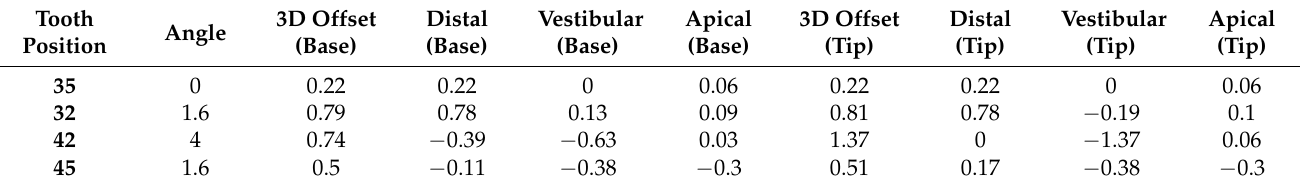
Table 2. Accuracy analysis with postoperative CBCT of the